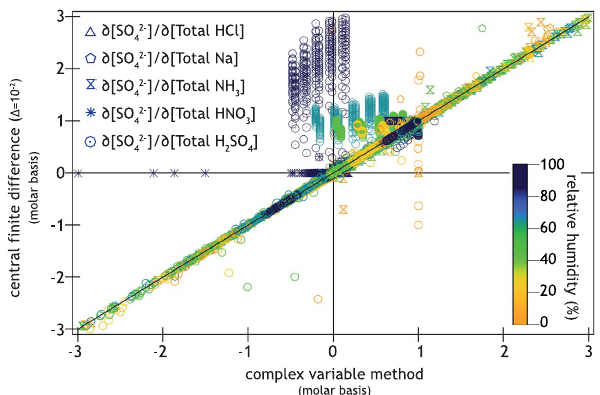
Fig. 3. Sensitivities from the central finite difference method with a delta value of 10 − 2 compared against sensitivities from the complex variable method with a perturbation of 10 − 18 i . The line y = x is plotted for reference (solid black). Deviations from stoichiometric expectations in finite difference sensitivities revealed that the finite difference approach would not suffice to evaluate ANISORROPIA